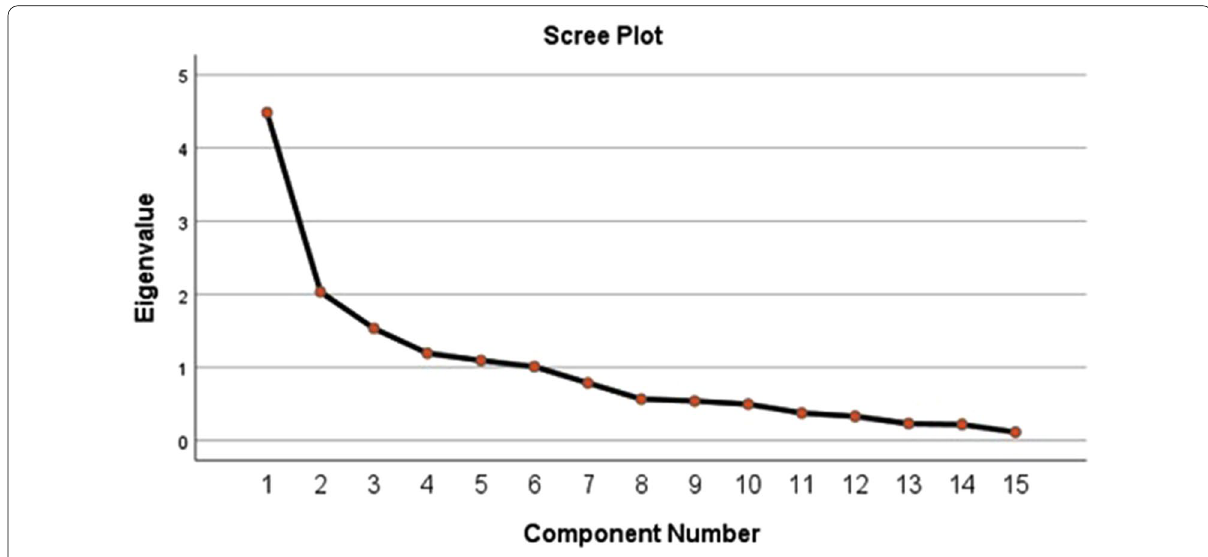
Fig. 4 Scree plot